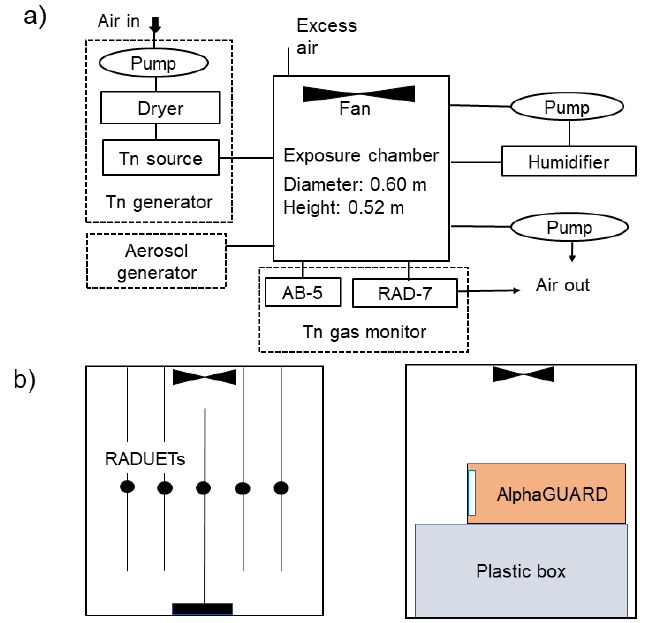
Figure 2. Schematic representations of the thoron calibration chamber system ( a ) and experimental setup for exposures of the RADUETs and AlphaGUARD to thoron ( b ). Panel ( a ) is modified from Pornnumpa et al. [33].